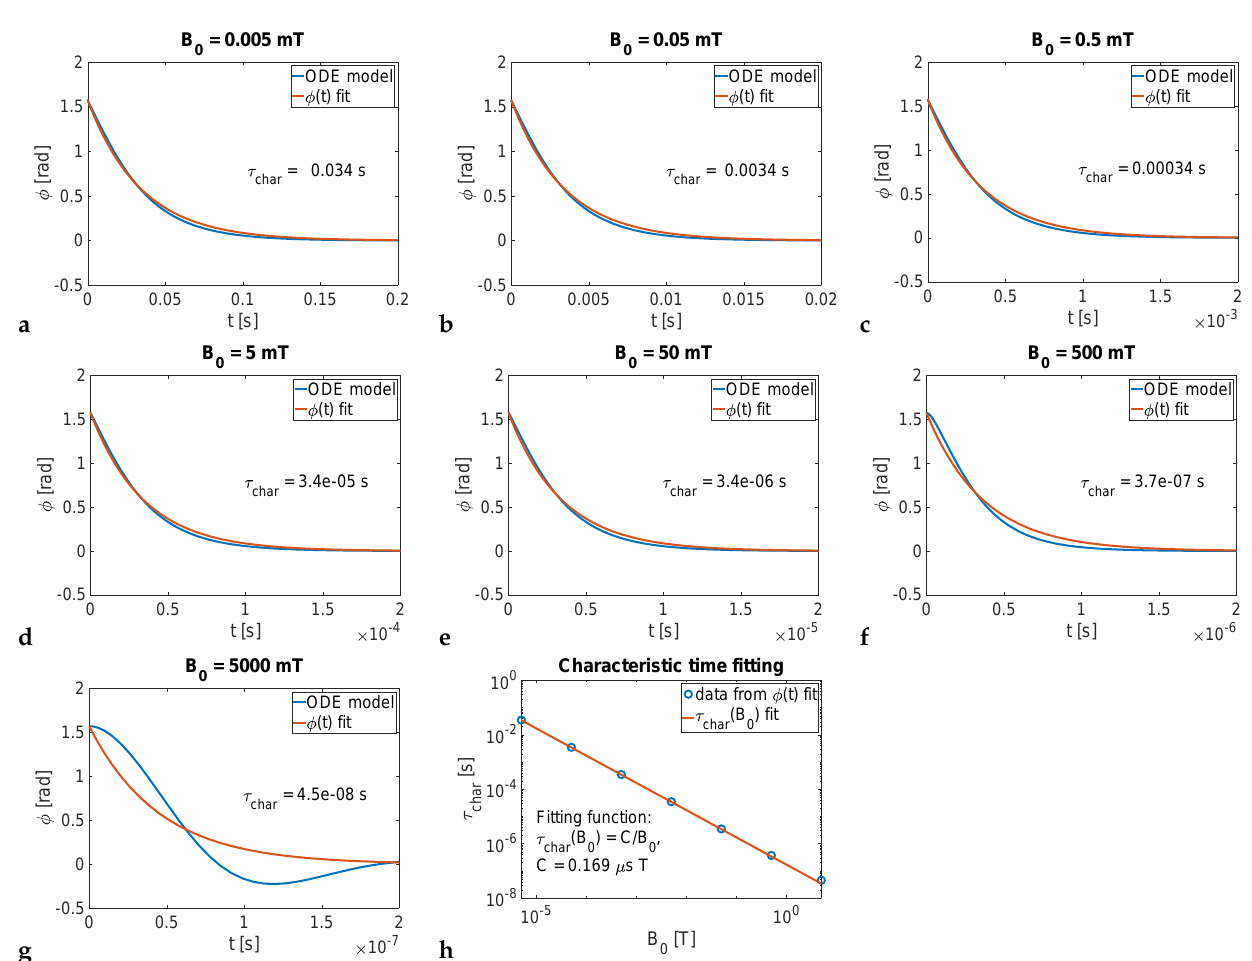
Figure 4. Least-square minimization fit of time evolution ϕ ( t ) for the simplest ODE model using function (18) and obtained estimates of characteristic time of magnetic particle alignment for each value of B 0 in the range from 5 µ T to 5T shown in panels ( a – g ), respectively; and the ( h ) least-square minimization fit of the characteristic time dependence on magnetic flux density norm τ char ( B 0 ) using Equation